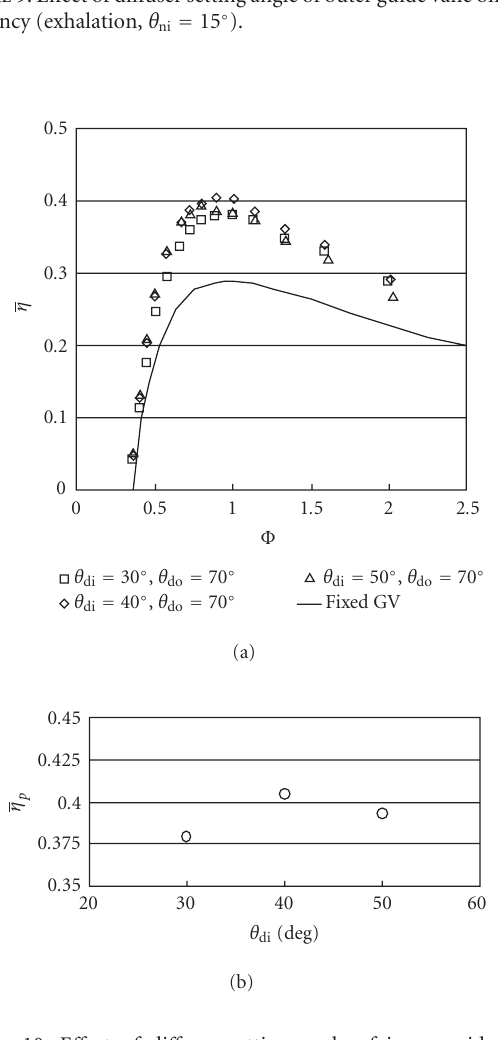
Figure 10: E ff ect of di ff user setting angle of inner guide vane on turbine characteristics under sinusoidal flow conditions ( θ ni = θ no = 15 ◦ ). (a) Mean e ffi ciency. (b) Peak e ffi ciency.